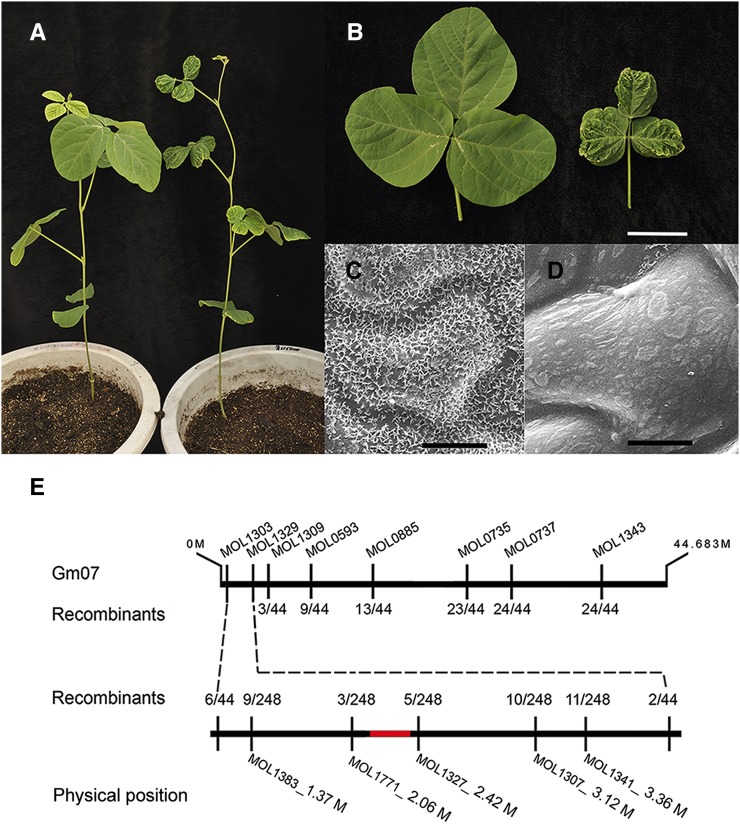
Phenotypes of the crinkly leaf mutant and fine-mapping of the mutated locus. (A) Whole plant of the crinkly leaf mutant (right), compared with the wild-type Hedou 12 (left) 40 days after sowing. (B) The third compound leaf of wild-type Hedou 12 (left) and the crinkly leaf mutant (right) from 40-day-old plants. Scale bar, 4 cm. Scanning electron microscope analysis for mature adaxial leaf epidermal cells of the wild type Hedou 12 (C) and the crinkly leaf mutant (D). Scale bar in (C) and (D), 8.6 μm. (E) Mapping of the crinkly leaf mutant. The upper horizontal line represents soybean chromosome Gm07, INsertion/DELetion markers and the number of recombinants between the marker and CRINKLY LEAF locus are shown above and below vertical lines. The red horizontal line represents the deletion region.